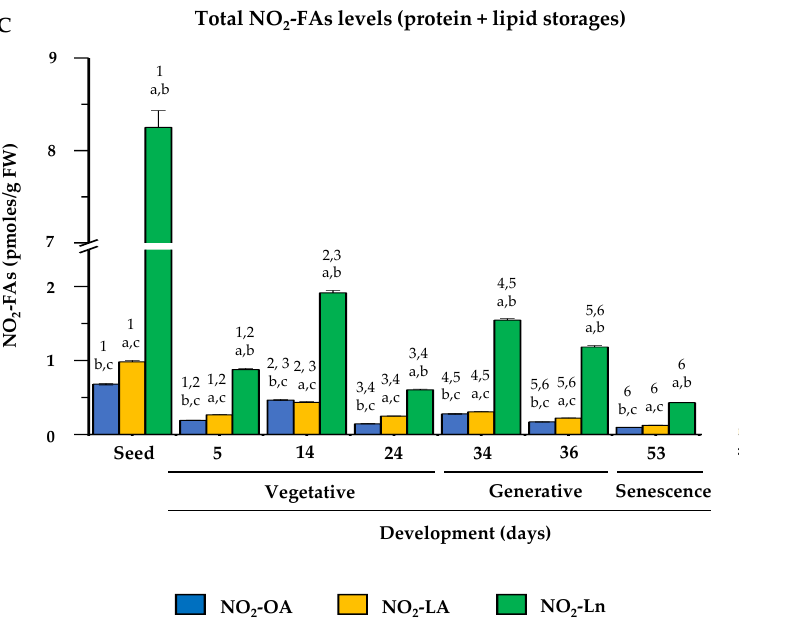
Figure 4. NO 2 -FAs endogenous levels during Arabidopsis development. This figure shows the quantification of the NO 2 -OA, NO 2 -LA, and NO 2 -Ln contents in the different plant development stages, which ranged from seed and vegetative stages (seed germination (at 5 days) and initial and complete rosette development (at 14 and 24 days, respectively)), generative stage (flowering (at 34 days), and seed production (at 36 days)) and senescence stage (at 53 days). Panel ( A ) displays the NO 2 -FAs endogenous levels esterified with the lipid storage biomolecules. Panel ( B ) shows the levels of the NO 2 -FAs from the adduction with the protein reservoir biomolecules. Panel ( C ) represents the total levels from the lipid and protein storages. The NO 2 -FAs values are the mean ± SEM of at least ten independent experiments. The statistical significance between means was analyzed by the Student’s t -test. Letter a indicates significant differences ( p < 0.05) between the NO 2 -OA levels to the other two NO 2 -FAs in each developmental stage. This same statistical comparison was also made for NO 2 -LA and NO 2 -Ln. Significant differences ( p < 0.05) are denoted by letters b and c, respectively. A comparison of each amount of NO 2 -FA in the different developmental stages was also made. Numbers 1, 2, 3, 4, 5, and 6 respectively indicate the significant differences ( p < 0.05) between: the NO 2 -FAs levels in the seedlings and 5-day-old plants; the 5- and 14-day-old plants; the 14- and 24-day-old plants; the 24- and 34-day-old plants; the 34- and 36-day-old plants; and the 36- and 53-day-old